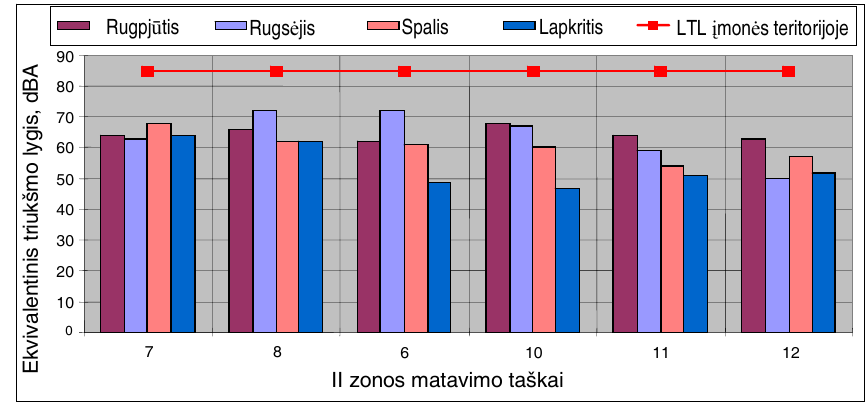
Fig 3. Measuring points of day-time reciprocal noise level on enterprise territory of zone II